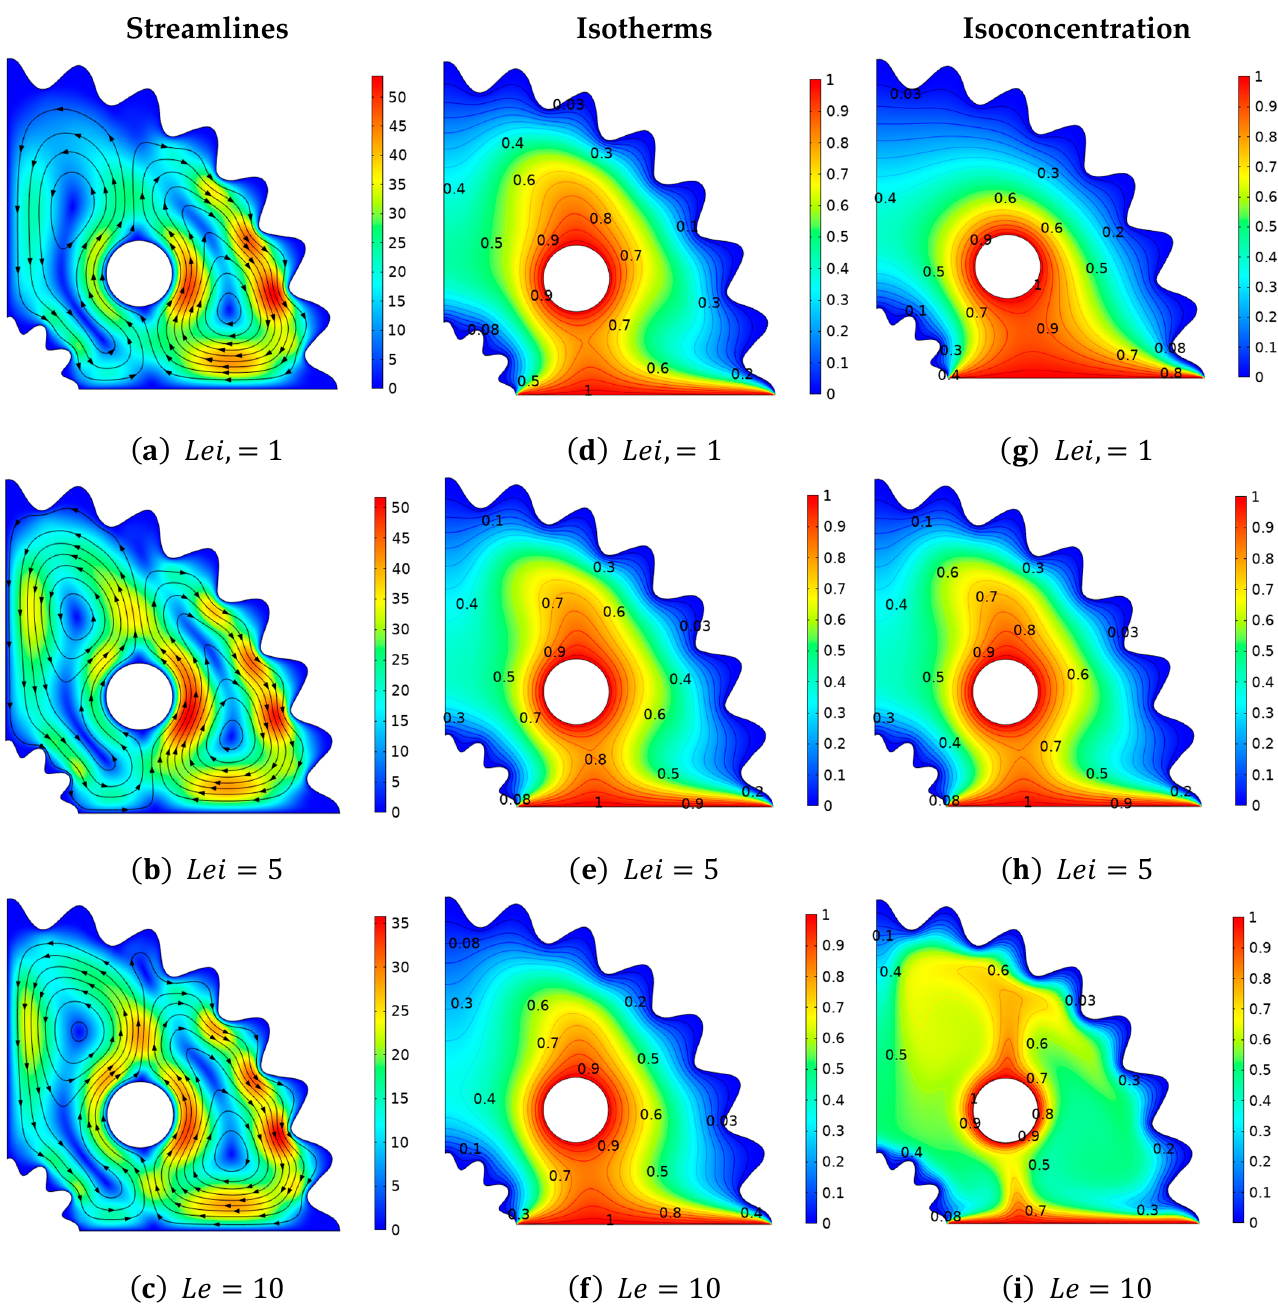
Figure 8. Deviation of ( a – c ) stream lines, ( d – f ) isotherms, and ( g – i ) isoconcentration with respect to the Lewis number ( Le ). Table 5. Average kinetic variation for different Hartmann numbers (Ha) and Casson parameters ( β